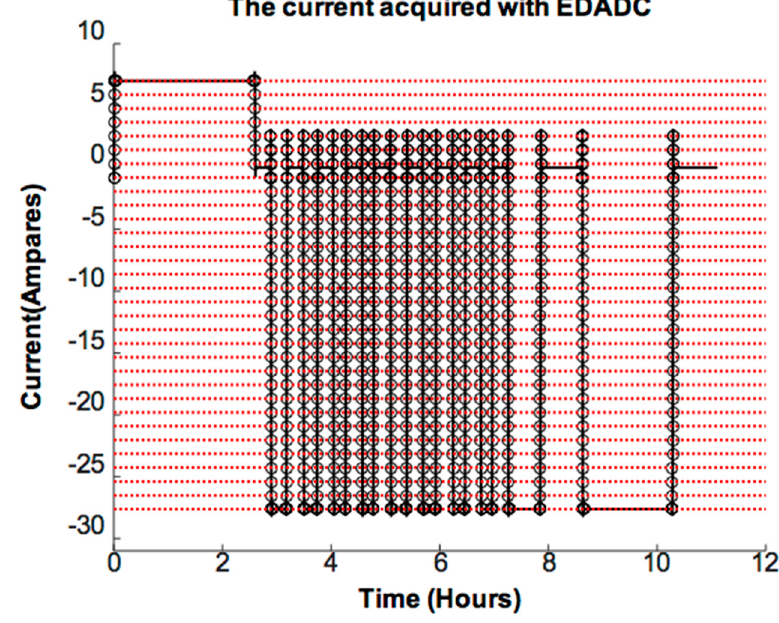
Figure 11. The current, acquired with 5-bit resolution uniform EDADC.